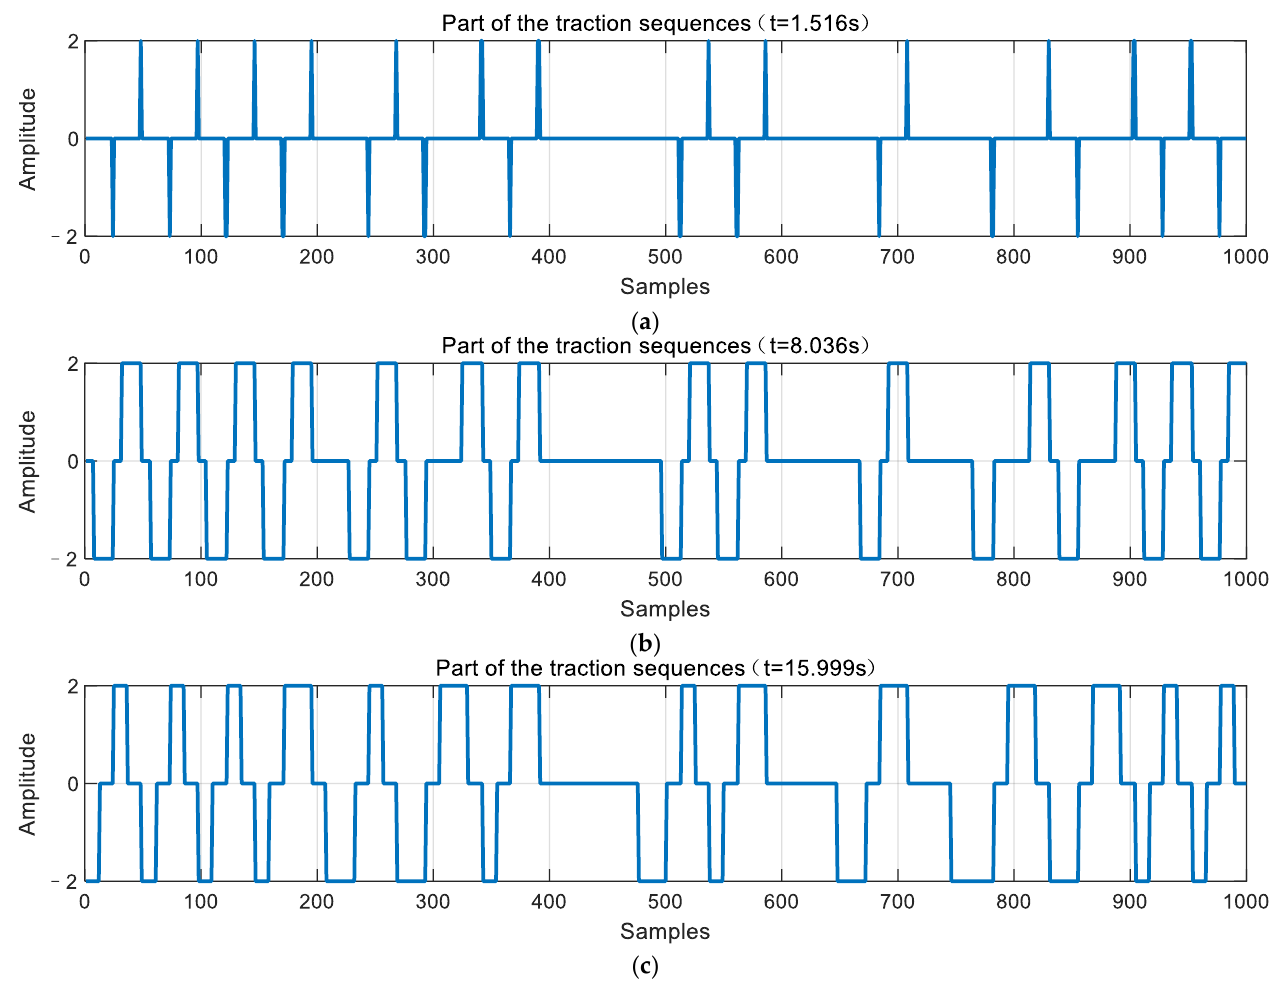
Figure 8. Transition process of traction code sequence. ( a ) Initial form of traction code; ( b ) Intermediate form of traction code; ( c ) Final form of traction code.